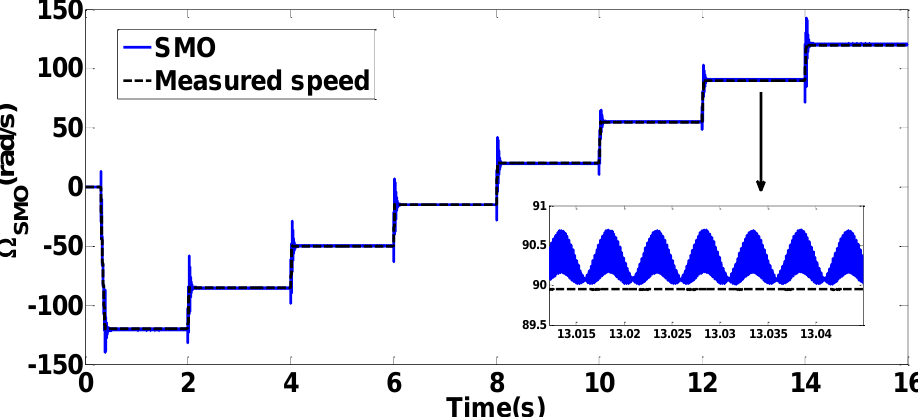
Figure 7. Estimated velocity response using of SMO at medium- and high-velocity operation ranges.